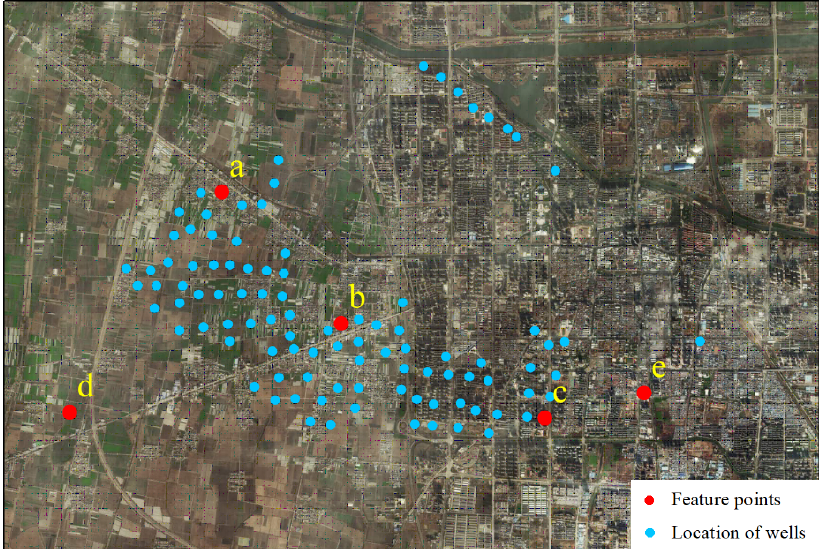
Figure 7. Feature points distribution and wells location around the study